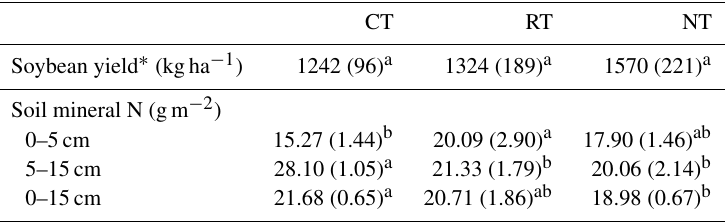
Table 1. Effects of tillage systems on soybean yield and the cumulative mineral N concentrations (standard deviation – SD) during the soybean growing season.